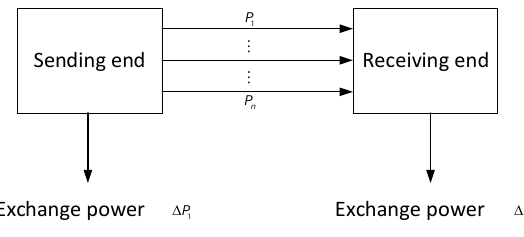
Figure 5. Transmission channel figure.